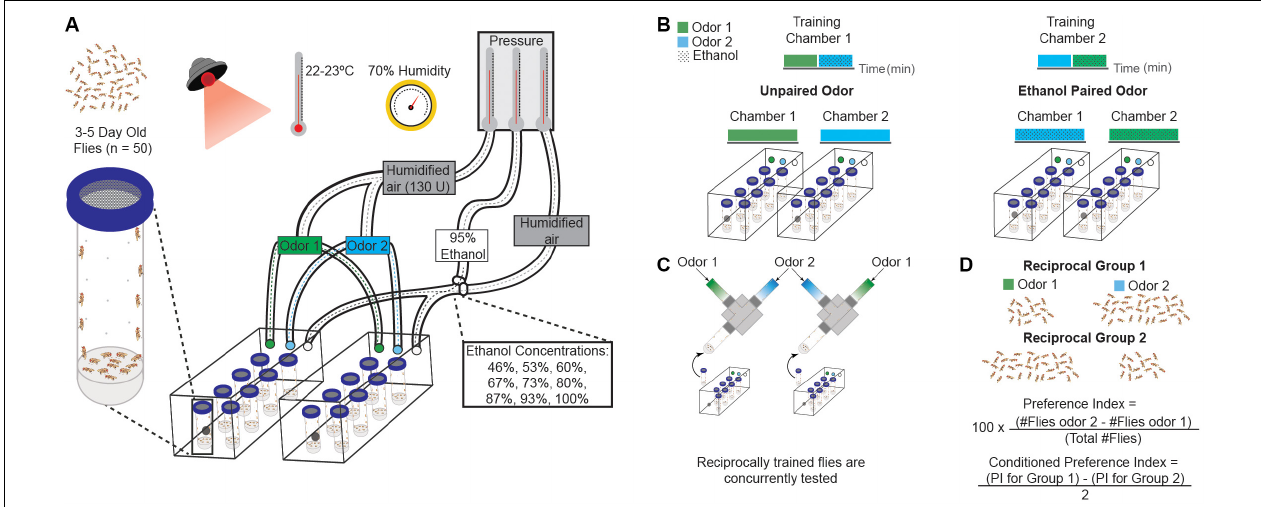
FIGURE 1 | Ethanol conditioning assay. (A) Schematic of behavioral training apparatus and fly training conditions. Behavioral training is done under red light, with temperature and humidity controlled throughout. Male flies ( n = 50) are transferred into perforated vials with 1 mL of 1% agar and acclimated in the behavioral boxes for 15 min with 130 U of humidified air. Air pressure for ethanol and humidified air is controlled to adjust the administered dose. A passive vacuum is present within the behavioral boxes for air/odorant removal. (B) Olfactory-cues are paired with vaporized ethanol during training. Varying ethanol concentrations are achieved by adjusting the flow rates of 95% vaporized ethanol and humidified air. Flies are trained with two neutral or appetitive odors: one unpaired with the ethanol and the other paired with ethanol. A reciprocal paradigm is used to control for innate odor preference. (C) Flies are tested with the two odor cues in a Y-maze (displayed above). Reciprocally trained flies are tested concurrently. (D) A preference index (PI) is calculated by subtracting the flies that move towards odor one from the flies that move towards odor two, dividing the resultant number by the total number of flies, and multiplying that number by 100. A conditioned preference index (CPI) is calculated by subtracting the preference index for odor two from the preference index for odor one and dividing the resulting number by two. A positive CPI value indicates preference, while a negative value indicates aversion. Each individual sample (N) is composed of 100